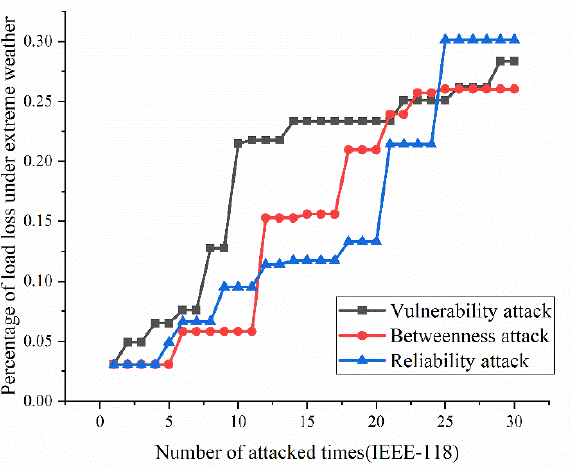
Figure 23. Load loss ratio of IEEE-118 bus system under extreme weather.